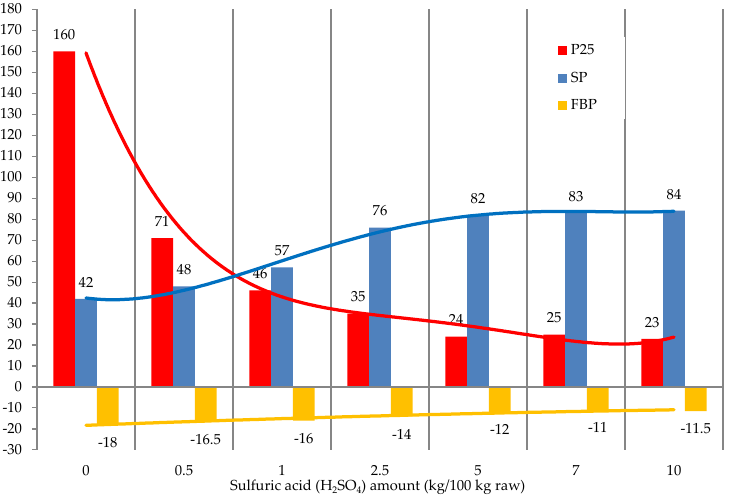
Figure 7. The effect of catalyst amount (H 2 SO 4 ) on the modification process: raw is Т1; formalin amount (including formaldehyde) 10.0 (3.7) kg/100 kg raw; temperature 120 °C; duration 3 h.